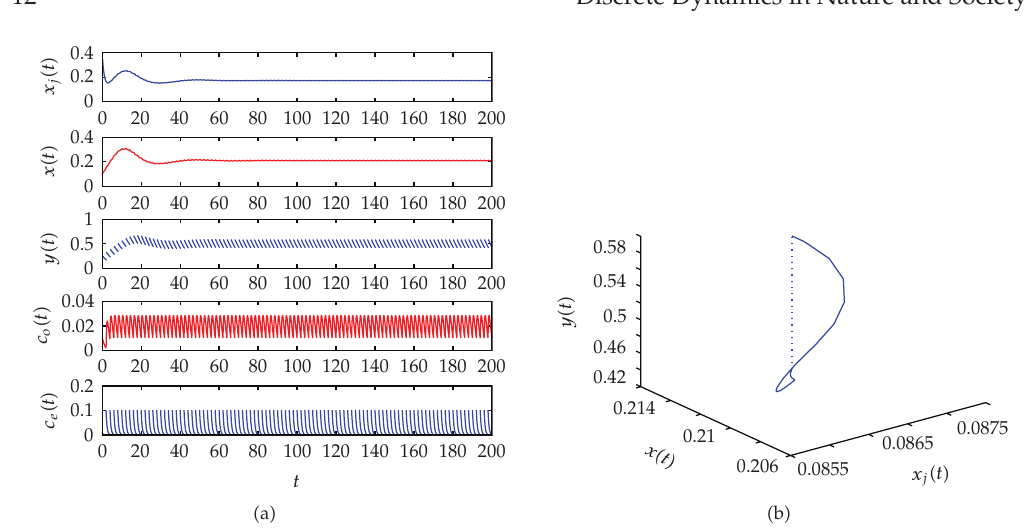
Figure 3: Dynamical behavior (cid:6) permanence (cid:7) of system (cid:6) 2.1 (cid:7) with a (cid:8) 0 . 8, b 1 (cid:8) 0 . 9, τ (cid:8) 0 . 7, f (cid:8) 0 . 2, β (cid:8) 0 . 9, η (cid:8) 1, r (cid:8) 0 . 7, b 2 (cid:8) 0 . 3, λ (cid:8) 0 . 9, k (cid:8) 1, g (cid:8) 0 . 5, m (cid:8) 0 . 7, h (cid:8) 2, l (cid:8) 0 . 1, and T (cid:8) 2, and μ 2 (cid:8) 0 . 1; initial value x j (cid:6) 0 (cid:7) (cid:8) 0 . 2, x (cid:6) 0 (cid:7) (cid:8) 0 . 1, y (cid:6) 0 (cid:7) (cid:8) 0 . 1, c o (cid:6) t (cid:7) (cid:8) 0 . 01, and c e (cid:6) t (cid:7) (cid:8) 0 . 01 (cid:6) ∗ corresponding theoretical criteria value: (cid:8) 0 . 1654 (cid:7) . (cid:6) a (cid:7) Time-series of system (cid:6) 2.1 (cid:7) with μ μ ∗∗ 1 finally tend to a T -periodic solution.